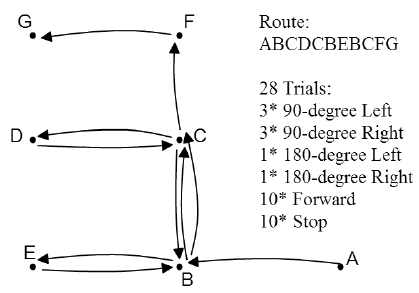
Figure 5. The predefined map contains number of rotations to the left and right in an open